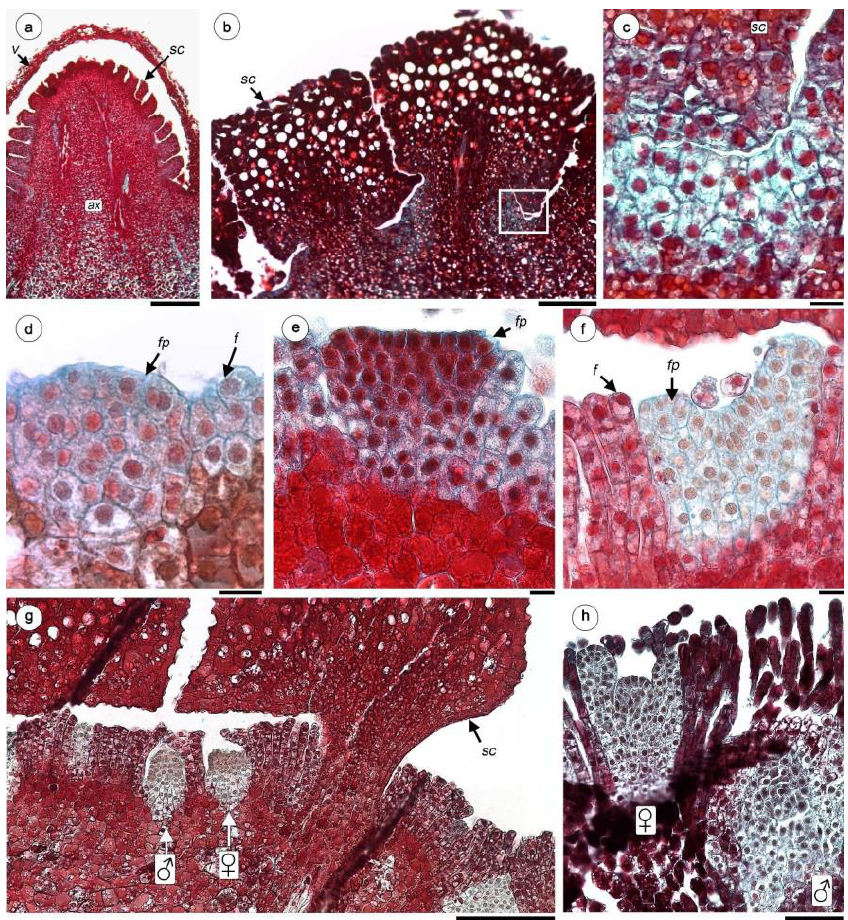
Figure 3. Female flower development of H. cayennensis (LM). ( a ) Inflorescence primordium still covered by volva. ( b ) Longitudinal sections of scales — note the meristematic tissue between them (box). ( c ) Detail of meristematic tissue [corresponds to box in ( b )]. ( d ) Floral and filariae primordium. ( e ) Flattened female floral bud. ( f ) Female floral bud with initiation of styles and stigmata. ( g ) Transection of young inflorescence showing female and male flowers between filariae, all pieces are still covered by scales. ( h ) Young male and female flowers primordium, the gynoecium is still open in the last. Abbreviations: ♀ : female flowers; ♂ : male flowers; ax: inflorescence axis; f: filariae; fp: female floral primordium; sc: scales; v: volva. Scales bar= ( a ) 0.5 mm; ( b, g, k ) 200 µm; ( c – f ) 20 µm.